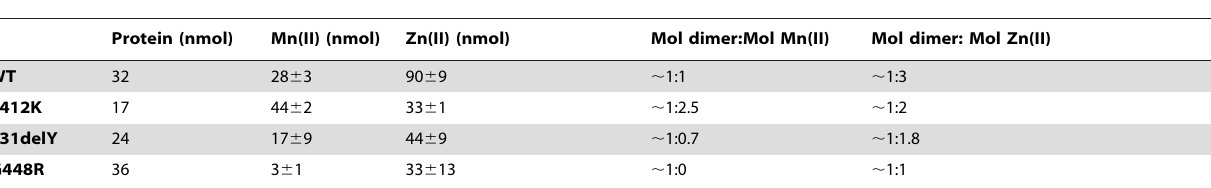
Table 2. Prolidase metal content.